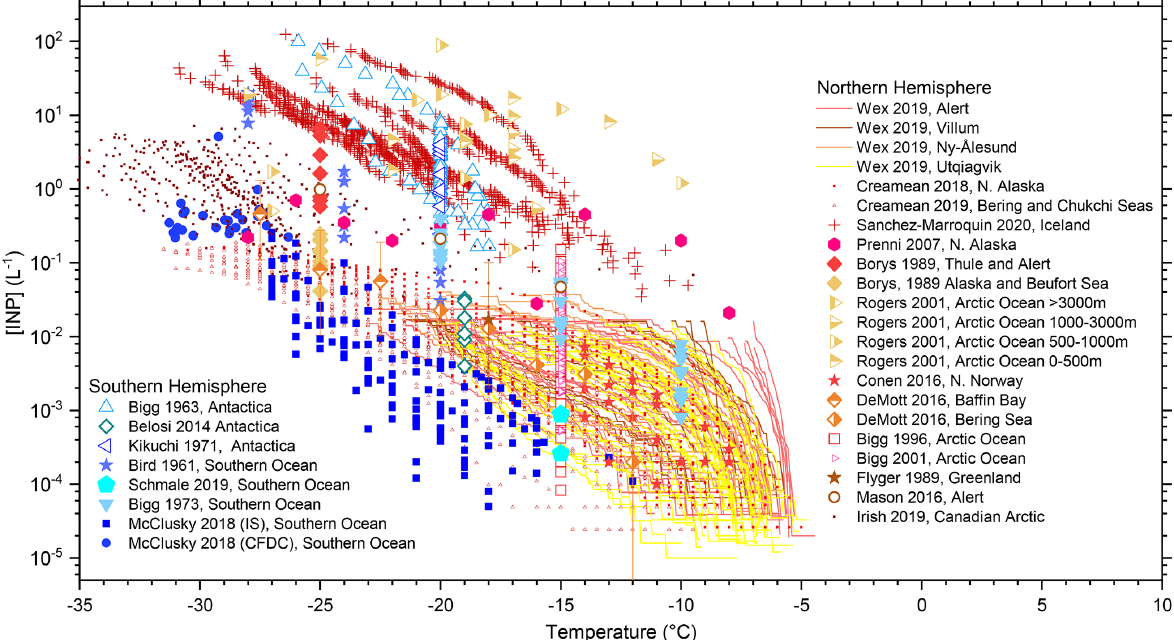
Figure 6. INP concentration measurements in the middle- to high-latitude Northern Hemisphere (yellows–reds) and the Southern Hemi- sphere (blues). Given INP sources in the middle to high latitudes are likely to be of central importance to CAOs, we have only presented measurements in either coastal regions or in the open ocean from latitudes greater than about 43 ◦ . At present we have no means of predicting this variability in INP concentration, because we are only beginning to quantitatively understand the sources relevant for these regions. Data were taken from multiple sources (Schmale et al., 2019; McCluskey et al., 2018a; Bigg, 1973; Bigg and Hopwood, 1963; Bird et al., 1961; Belosi et al., 2014; Kikuchi, 1971; Sanchez-Marroquin et al., 2020; Wex et al., 2019; Irish et al., 2019a; Creamean et al., 2019; Creamean et al., 2018; Bigg, 1996; Bigg and Leck, 2001; Borys, 1989; Rogers et al., 2001; DeMott et al., 2016; Flyger and Heidam, 1978), and more de- tails are given in Table S1. While there is clearly a great deal of natural variability there are also differences in sampling and instrumentation that will cause some variability. A discussion of known artefacts associated with the technique employed by Bigg and co-workers has been given previously (Mossop and Thorndike, 1966; McCluskey et al.,